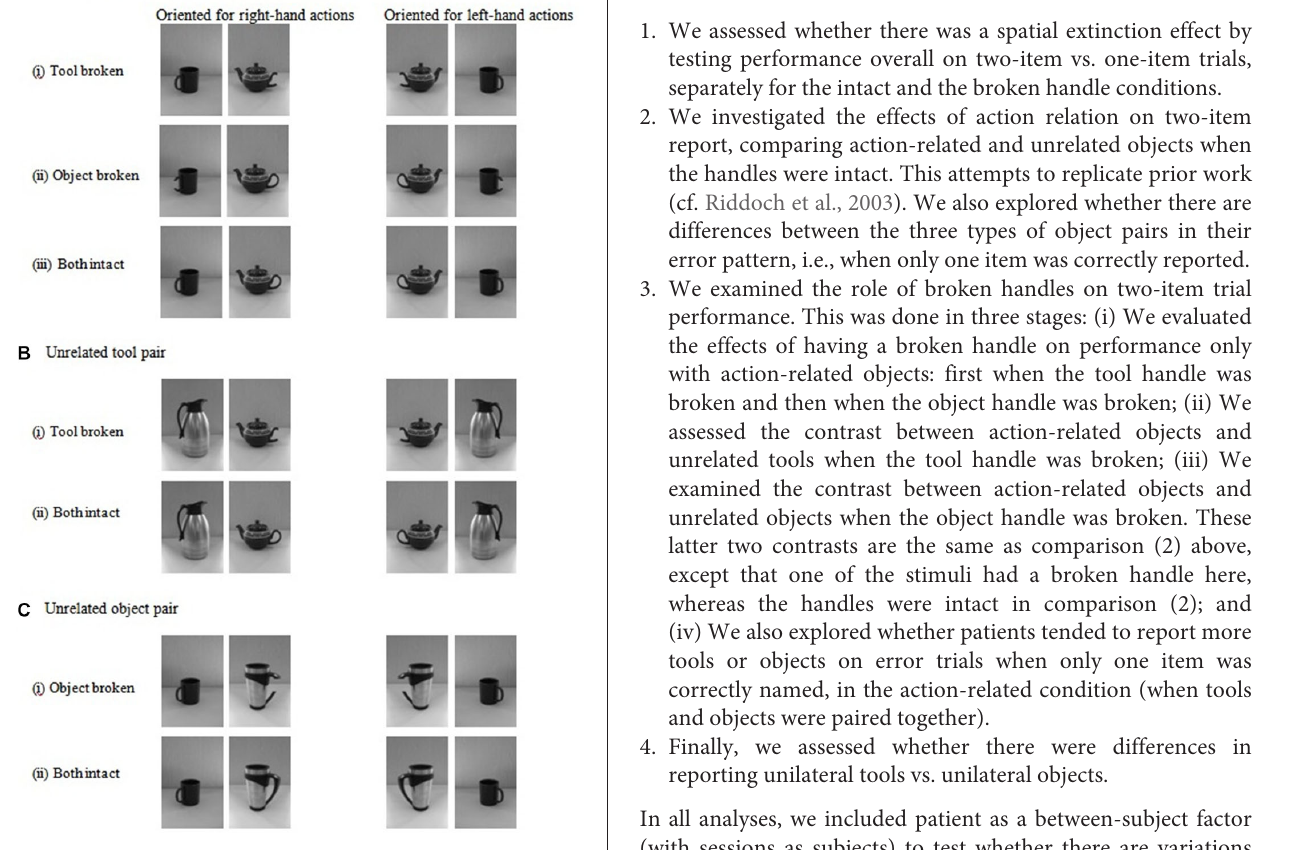
FIGURE 1 | Examples of two-item stimuli presented either as action-related pairs (object-tool pair) (A), unrelated tool-tool pairs (B) or as unrelated object-object pairs (C). The stimuli are shown with a broken handle on the contralesional side (left panels) or with a broken handle on the ipsilesional side (right panels).